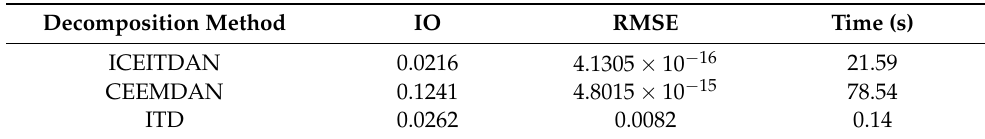
Figure 10. Comparison chart of the decomposition results of three methods: CEEMDAN, ICEITDAN, and ITD. ( a ) CEEMDAN, ( b ) ICEITDAN, and ( c ) ITD. Table 6. Comparison indicators for the three